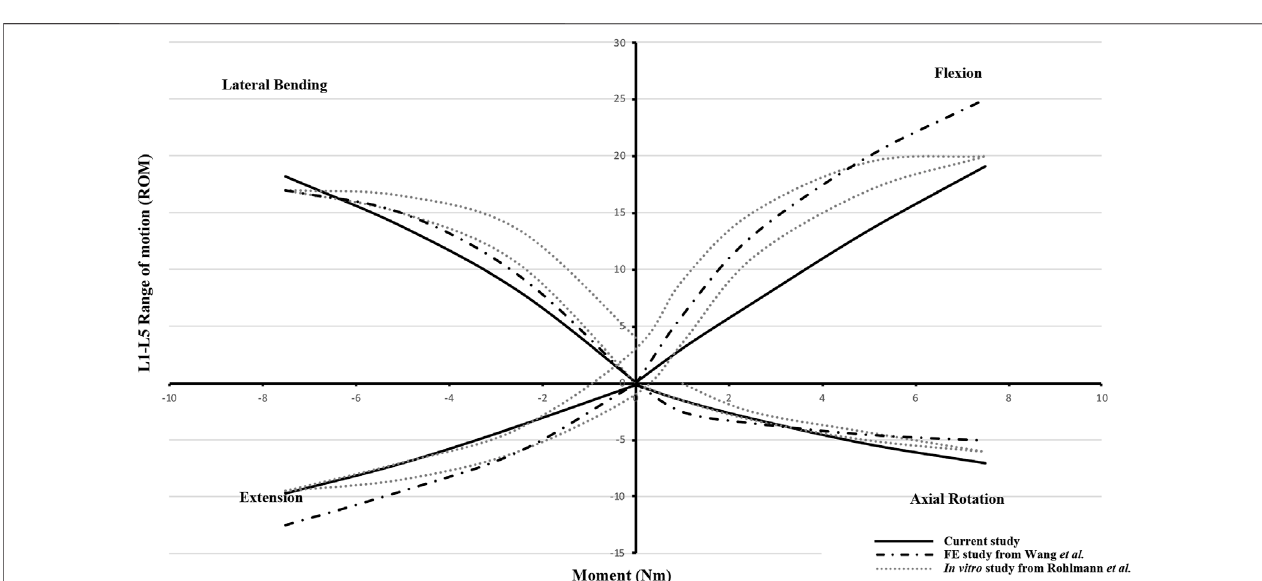
FIGURE 4 | Range of motion (ROM) – moment curvatures for model validation versus the FE study from Wang et al. and the in vitro study from Rohlmann et al.